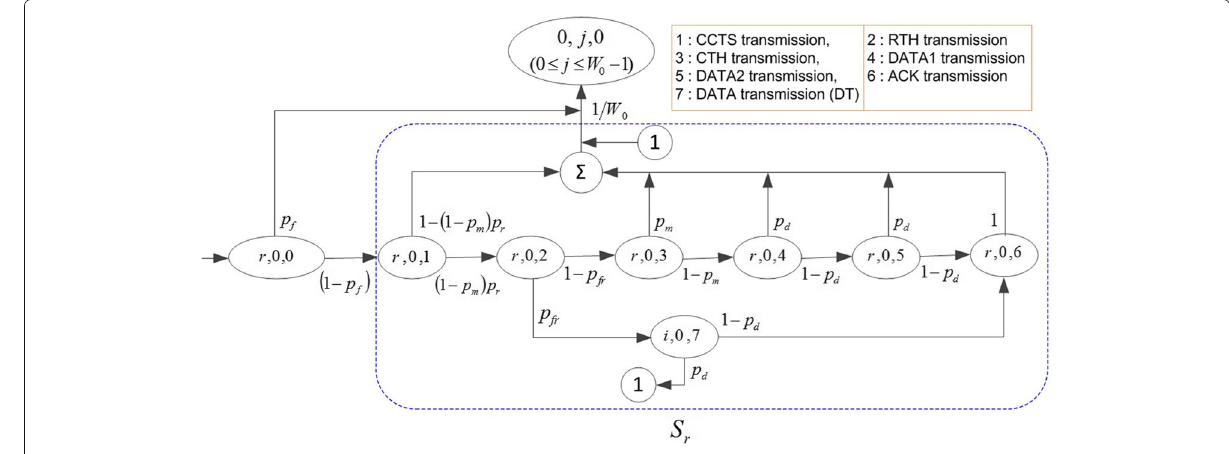
Fig. 8 State transition diagram for S